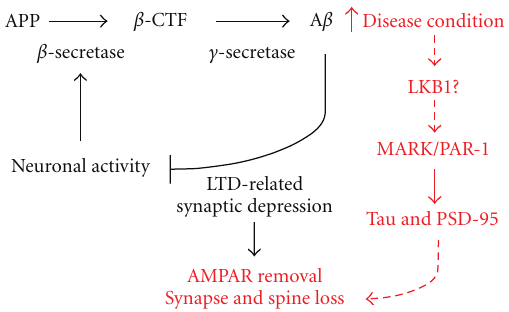
Figure 1: A diagram depicting the physiological and pathological roles of A β . The pathway in black represents the normal function of A β in restraining neuronal hyperactivation. In response to neuronal activation, there is upregulation of BACE, leading to overproduction of A β , which then acts through LTD-related mech- anism involving AMPAR removal to tune down neuronal activity. In disease condition (depicted in red), however, the excessive accumulation of A β leads to excessive synaptic depression and AMPAR removal, which eventually results in synapse and spine